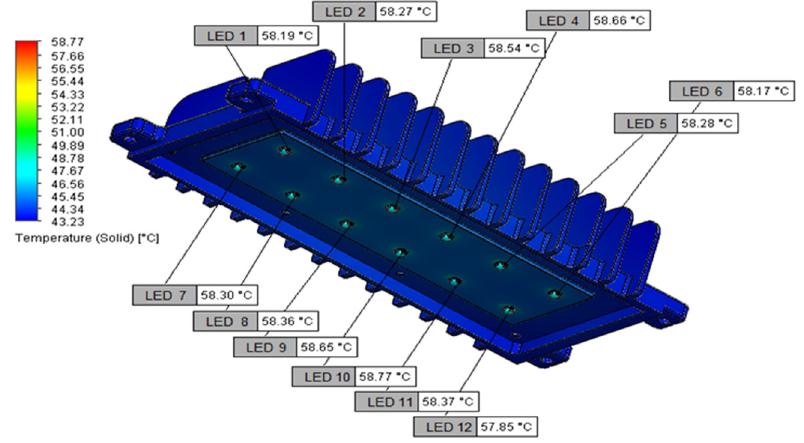
Figure 11. The distribution of panel temperature and junction temperature T j of panel sources for I F = 700 mA.